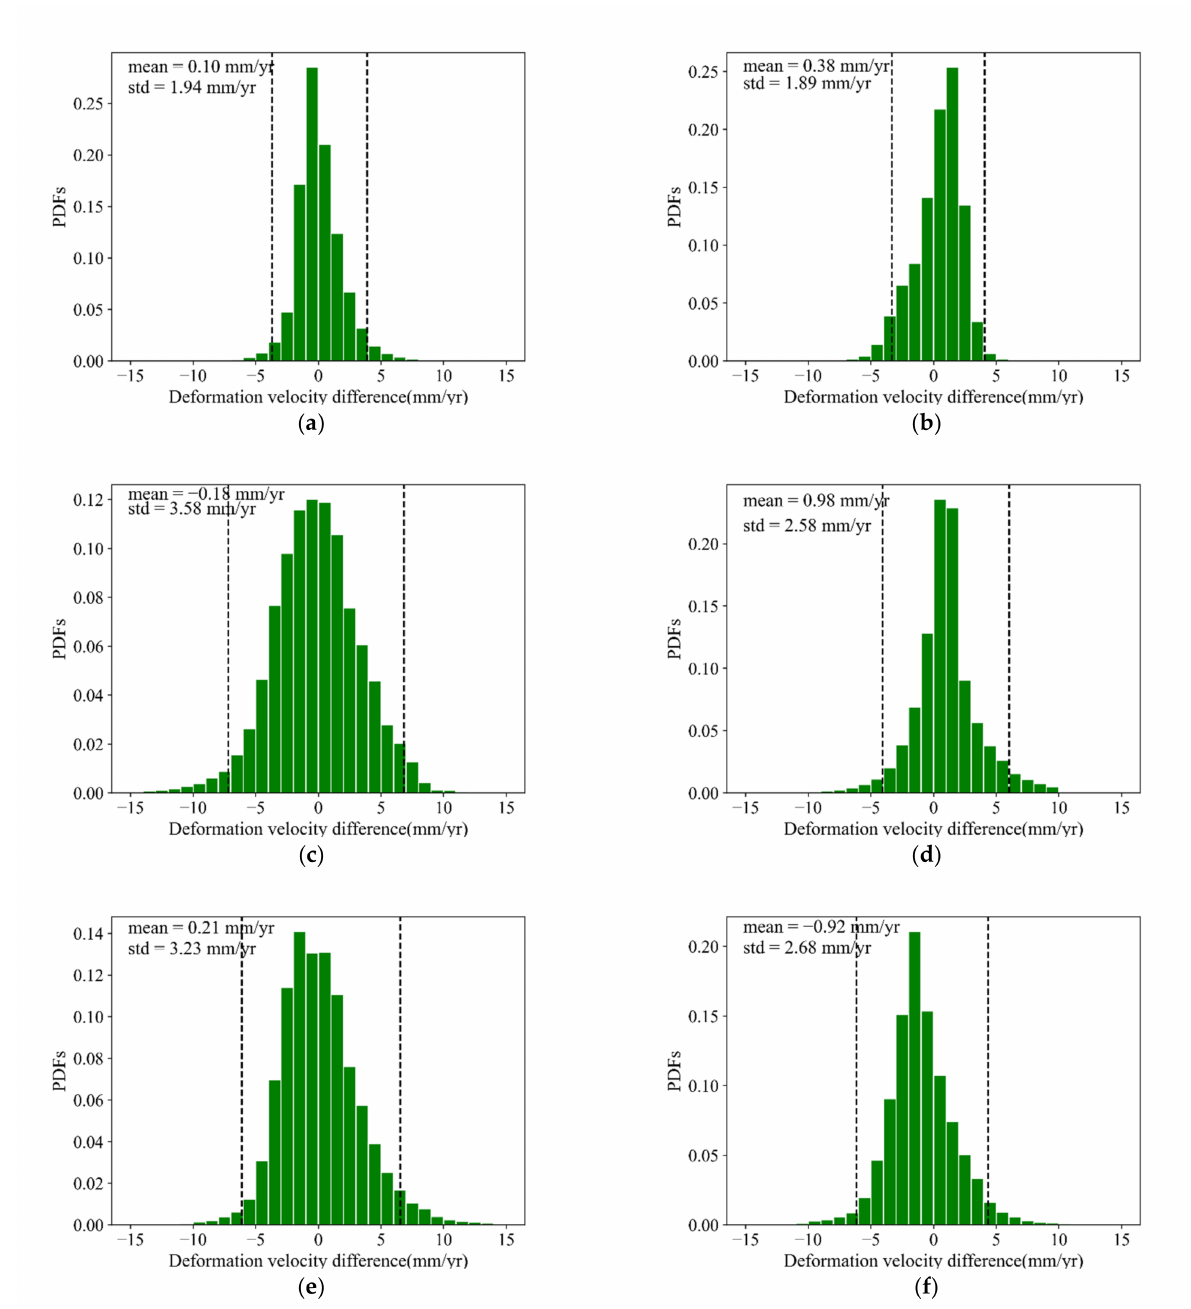
Figure 7. Histogram of deformation velocity difference in overlapping areas: ( a ) between data 158A_05451 and 085A_05455; ( b ) between data 085A_05455 and 012A_05443; ( c ) between data 019D_05619 and 121D_05668; ( d ) between data 026A_05128 and 099A_05217; ( e ) between data 143A_05651 and 150D_05505; and ( f ) between data 041A_05430 and 121D_05470. The black dashed line in the figure is 95% confidence